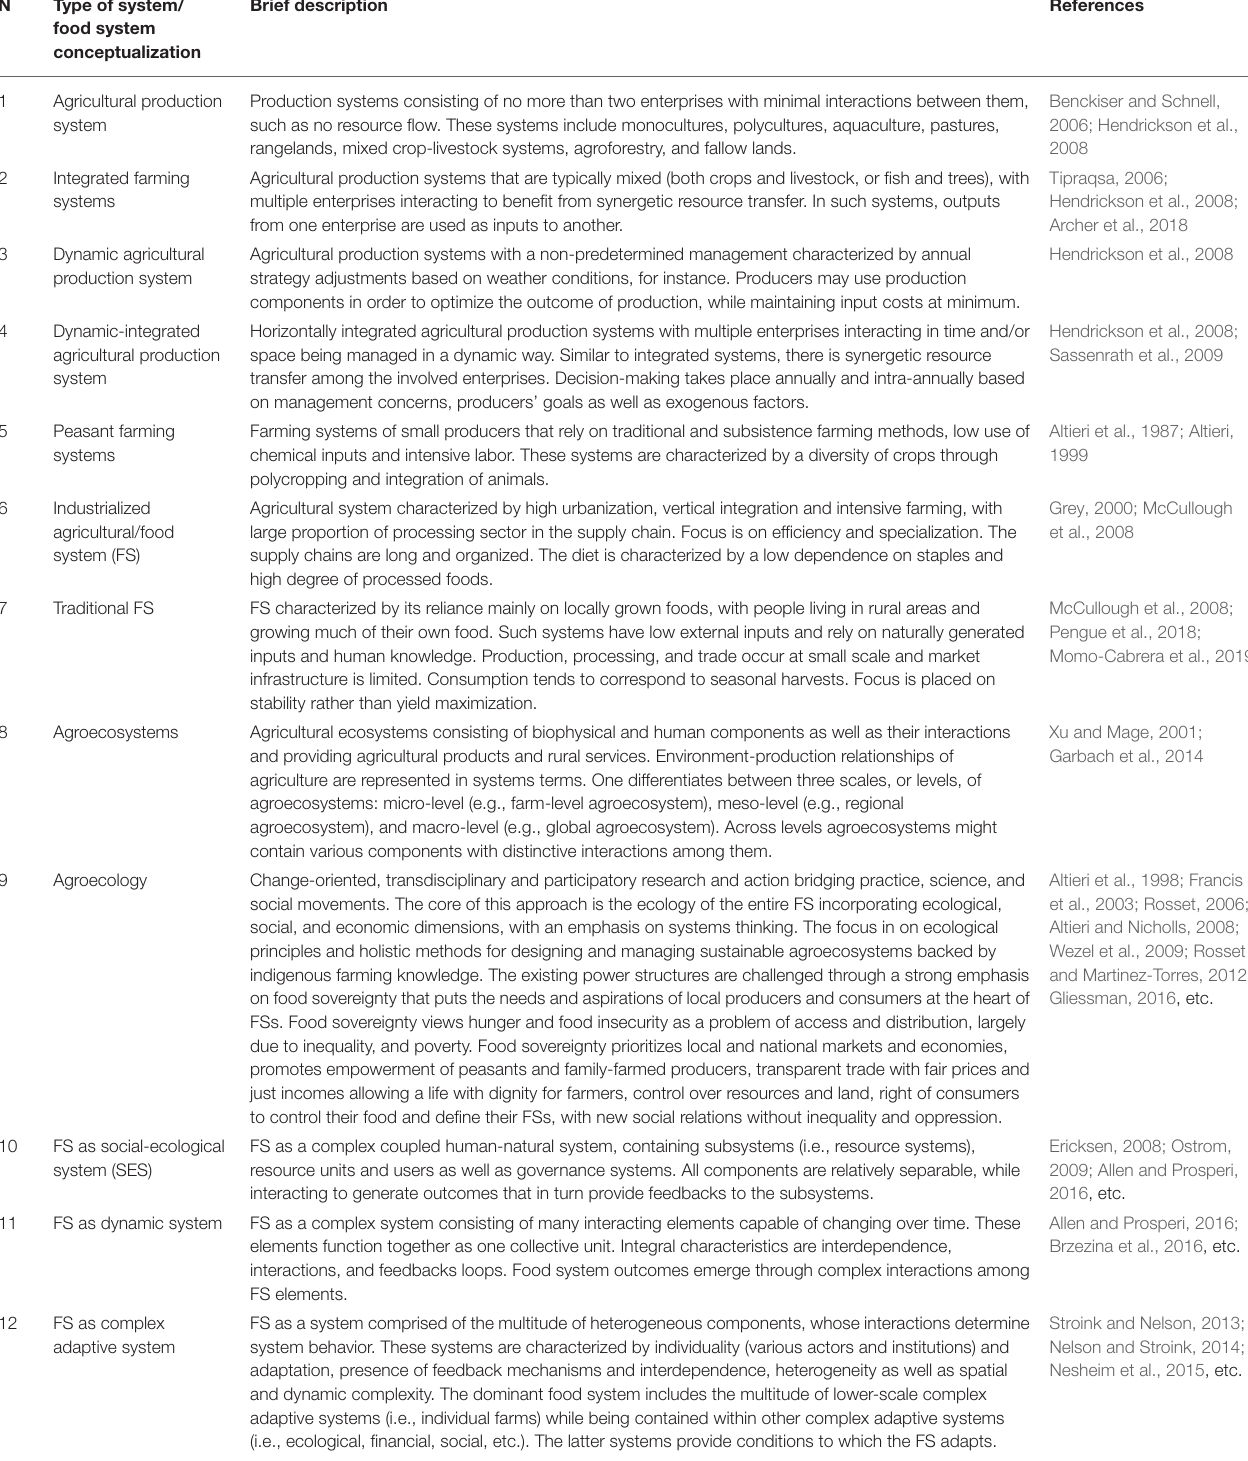
TABLE 1 | Selected agricultural and food systems, food system concepts, and their main characteristics.